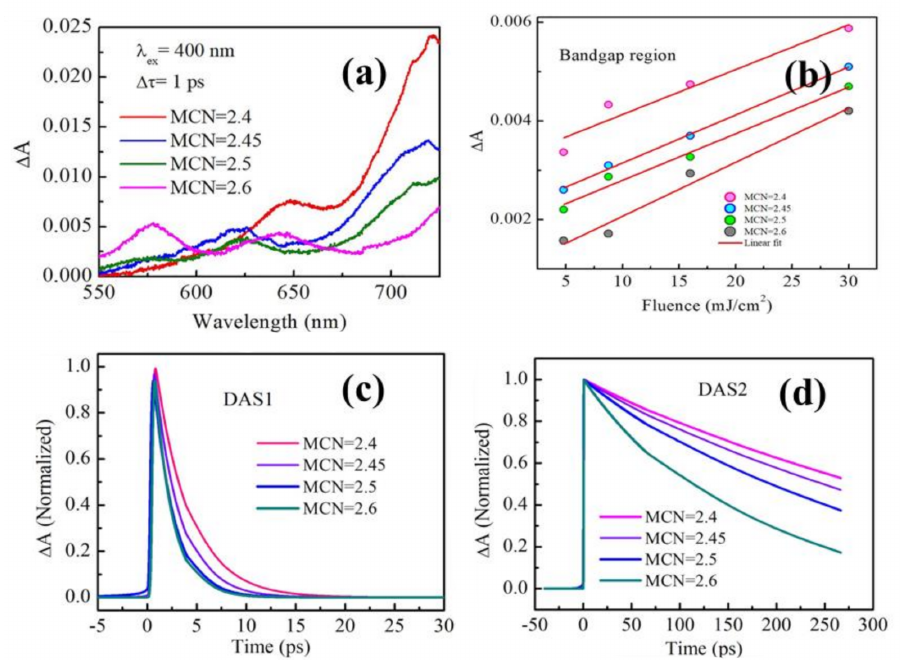
Figure 11. ( a ) TA spectra of a-Ge x As 35-x Se 65 thin films at probe delay of 1 ps when excited with 400 nm pump. ( b ) Variation of TA maxima in the bandgap region for all samples against laser fluence. Temporal evolution of central wavelengths associated with ( c ) DAS1 (sub-bandgap region) and ( d ) DAS2 (bandgap region). All Figures are reprinted with permission from [64] Copyright 2018, American Institute of